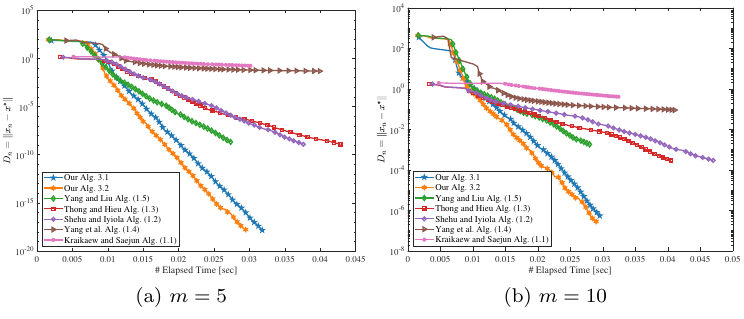
Figure 1. Numerical results for Example